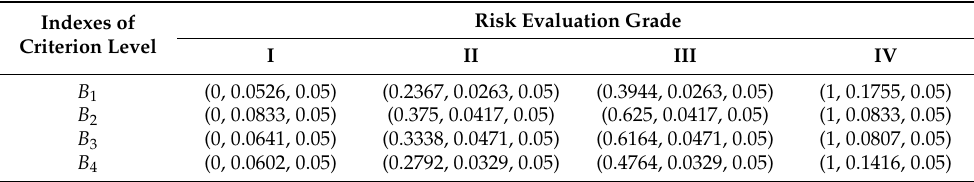
Table 7. Standard cloud digital features and evaluation grades in criterion level.